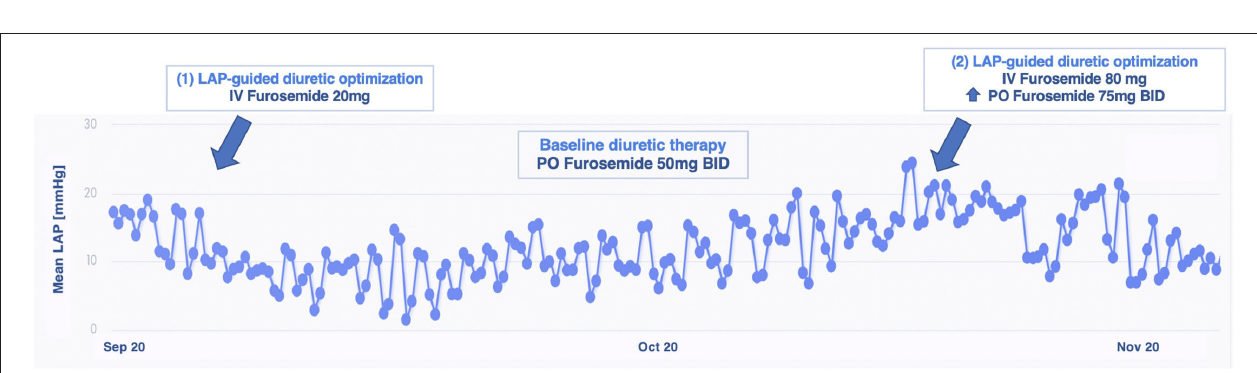
FIGURE 3 | Left atrial pressure fluctuations throughout the day in patient 2. (A) Before diuretic dosage adjustment, a clear difference in PM/AM values was observed over a 3-month period. (B) After diuretic dosage adjustment, these hour-to-hour variations were blunted. AM, ante meridiem; PM, post meridiem; LAP, left atrial pressure.